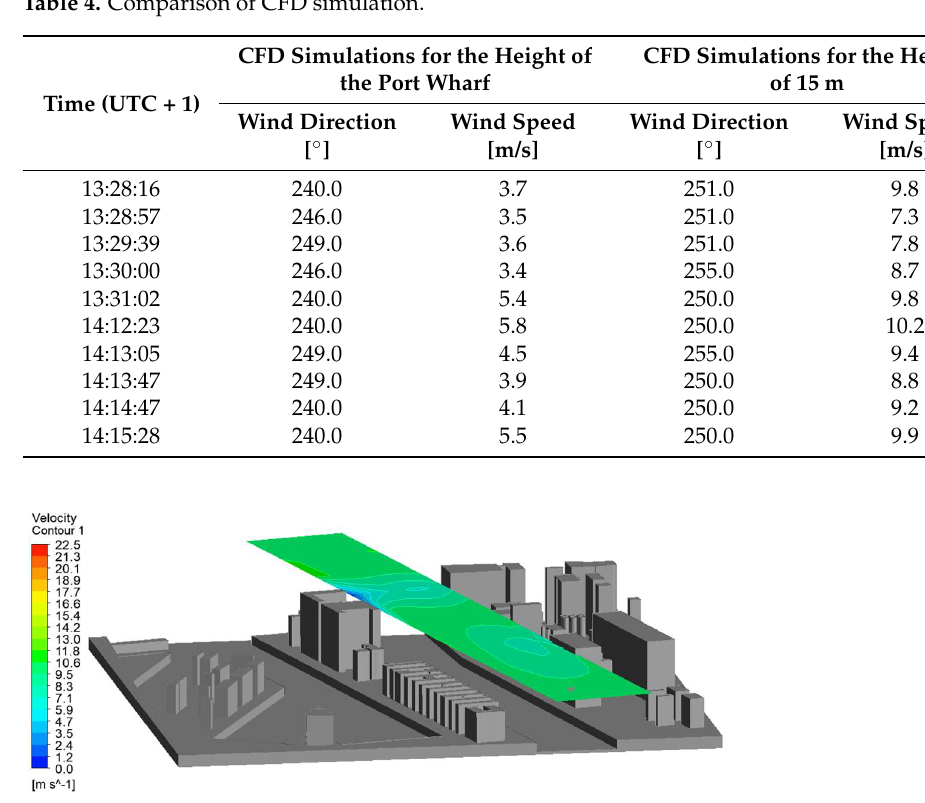
Figure 17. The simulation results presented for the horizontal plane at the height of 15 m, whereas Table 4 shows the values for the simulation at a height of 15 m. Table 4. Comparison of CFD simulation.